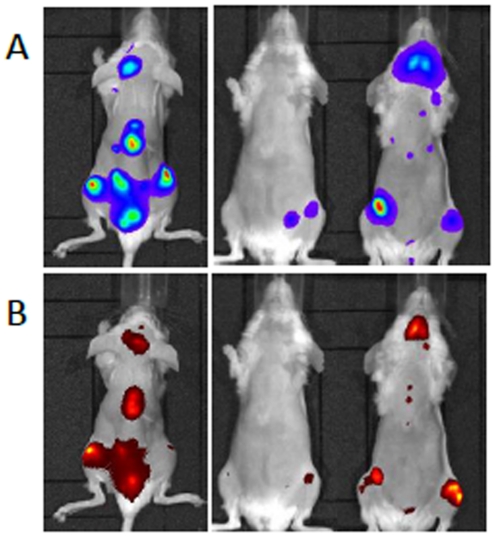
Bioluminescent (A) and fluorescent (B) of HL60-Luc tumor-bearing mice 48h post-injection of 1 µg fluorescent CD44 mAb.